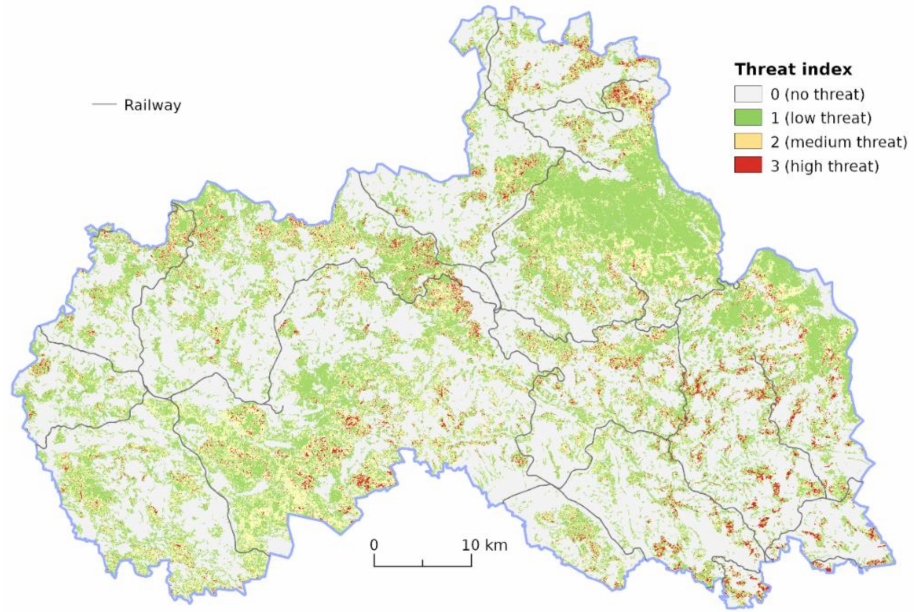
Figure 13. Threat indices (VTIR) for the entire Liberec Region. We analysed the surrounding 60-metre railway protection zone in more detail. A close examination of the maps with the VTIR values in the protected zone shows that the locations of greatest threat do not form large continuous areas, but small areas located outside the lower-threat areas. This detail may indicate gradually deteriorating conditions where vegetation is gradually expanding into the terrain (Figure